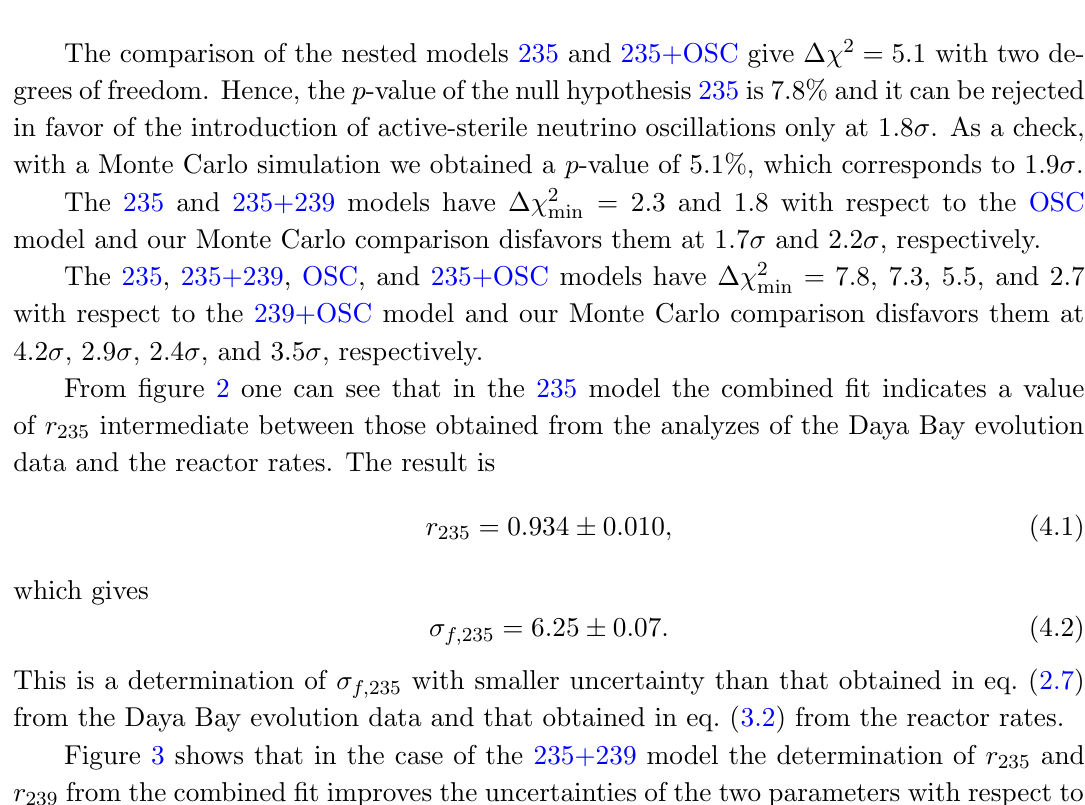
Table 3 . Fits of the reactor rates in table 1 of ref. [12] (without the 2016 Daya Bay rate) and the 2017 Daya Bay evolution data